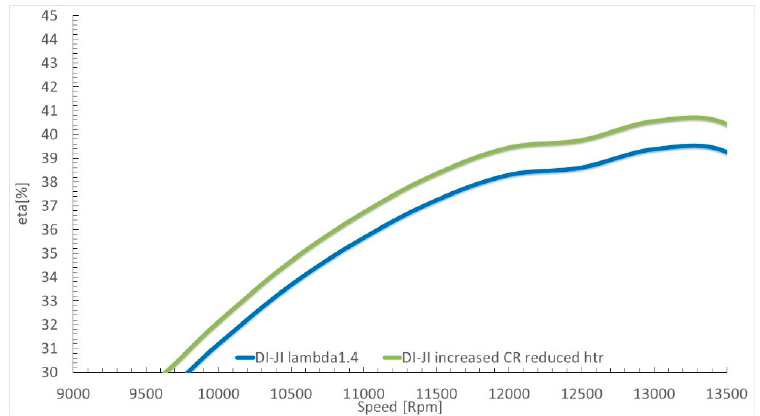
Figure 12. Fuel conversion efficiency of lean burn engines.